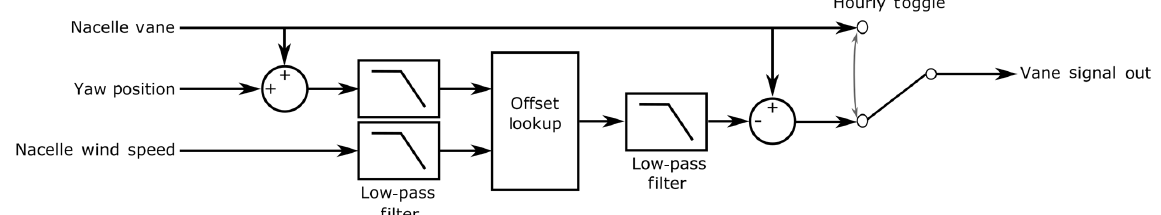
Figure 5. Block diagram of wake steering controller implementation. Inputs are provided by a typical turbine sensor, and the output is a modified vane signal to supply the turbine yaw controller for wake steering. Note that this output is toggled on–off hourly. All low-pass filters have a 30s time constant.